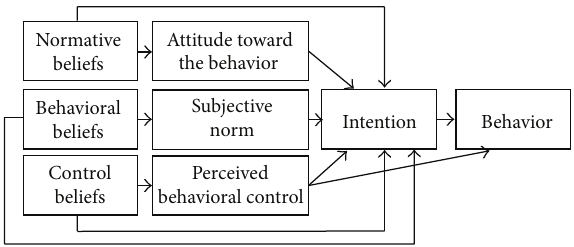
Figure1:Thetheoryofplannedbehavior(adaptedfromAjzen,1991)